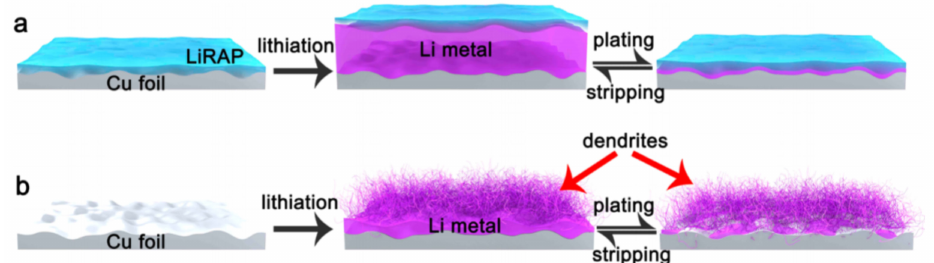
Figure 28. ( a ) Dendrite growth suppression in LiRAP/Cu substrate ( b ) Growth of dendrites without LiRAP in Cu-Li substrate (adapted with permission from [350] Nano Lett, ACS,